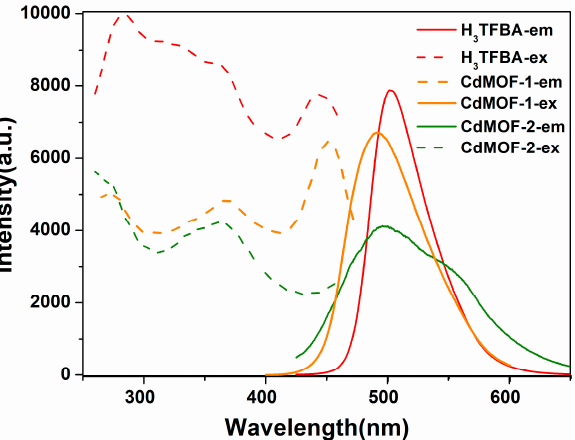
Figure 4. Emission spectra of H 3 TFBA 503 ( λ ex = 336 nm); CdMOF-1-2 in the solid state at room temperature.